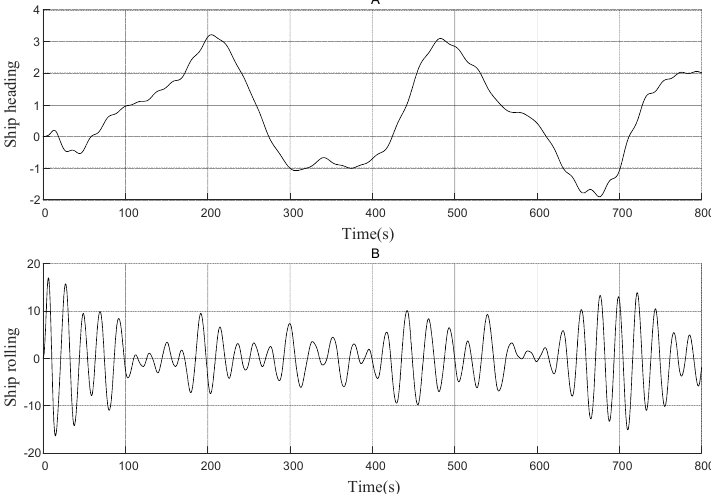
Figure 4. Heading ( A ) and rolling ( B ) angles of the ship without control